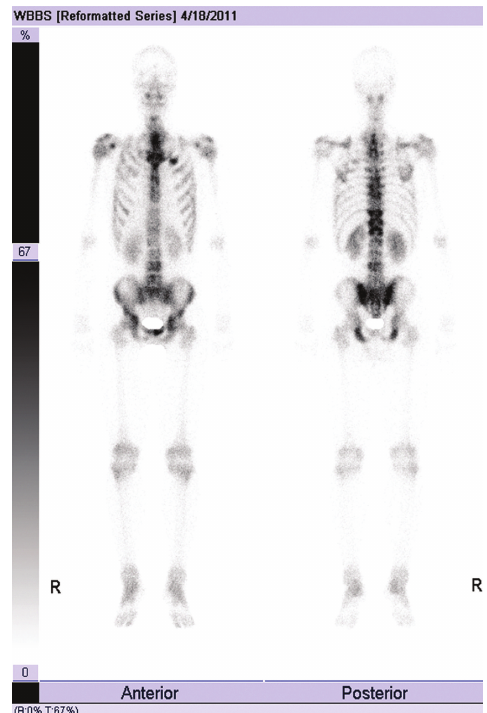
Figure 6: Tc-99m MDP WBBS showed ribs, spine, and pelvis intensively accumulated the agent and was very similar to the changes of multiple bone metastasis.